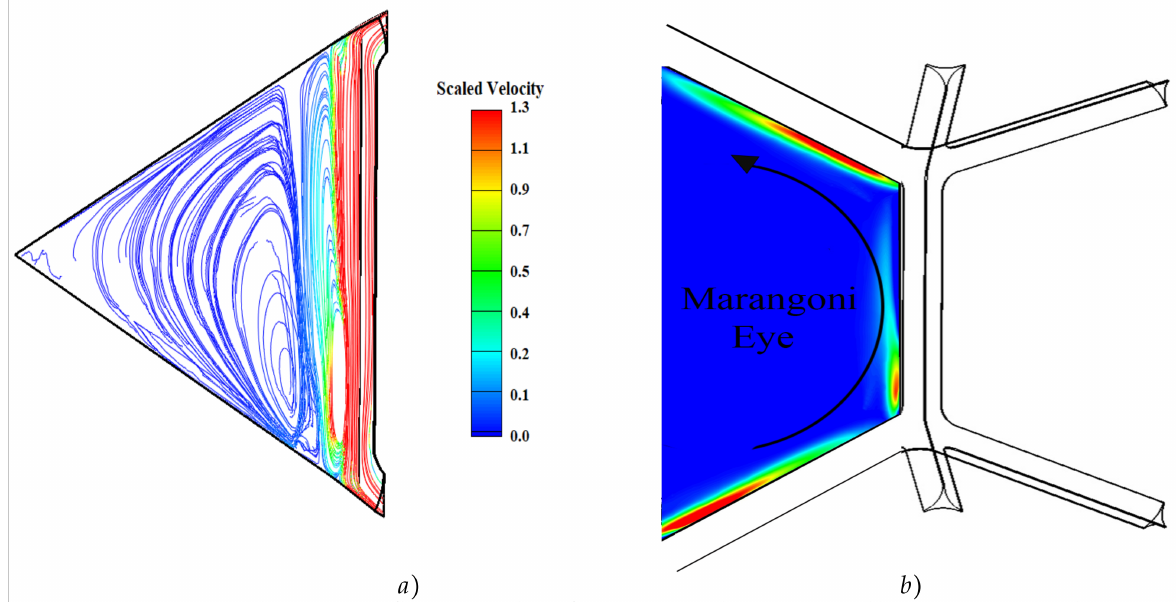
Figure 6. ( a ) Marangoni flow stream lines for an interior thin geometry ( b ) Marangoni eye, wherein red spots represent the maximum velocity of the Marangoni flow in transitional